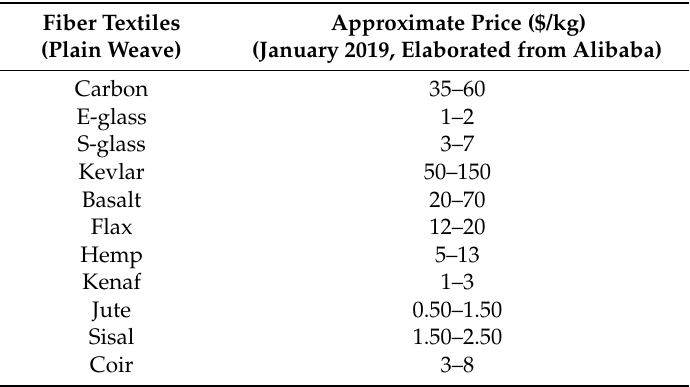
Table 2. The approximate price of fiber textile